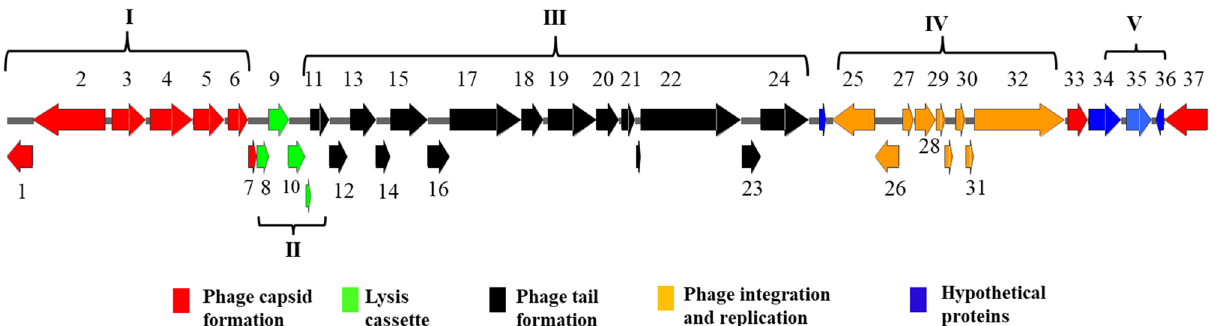
Figure 3. Salmonella phage BIS20 annotation map as generated by GeneMark.hmm, RAST and GAMOLA version 2 software. Different ORFs are color coded according to their putative functions. Numbers at each ORF correspond to their description in Supplementary Tables S4 and S5. For ease of description genome is divided in to five modules represented by Roman numerals and